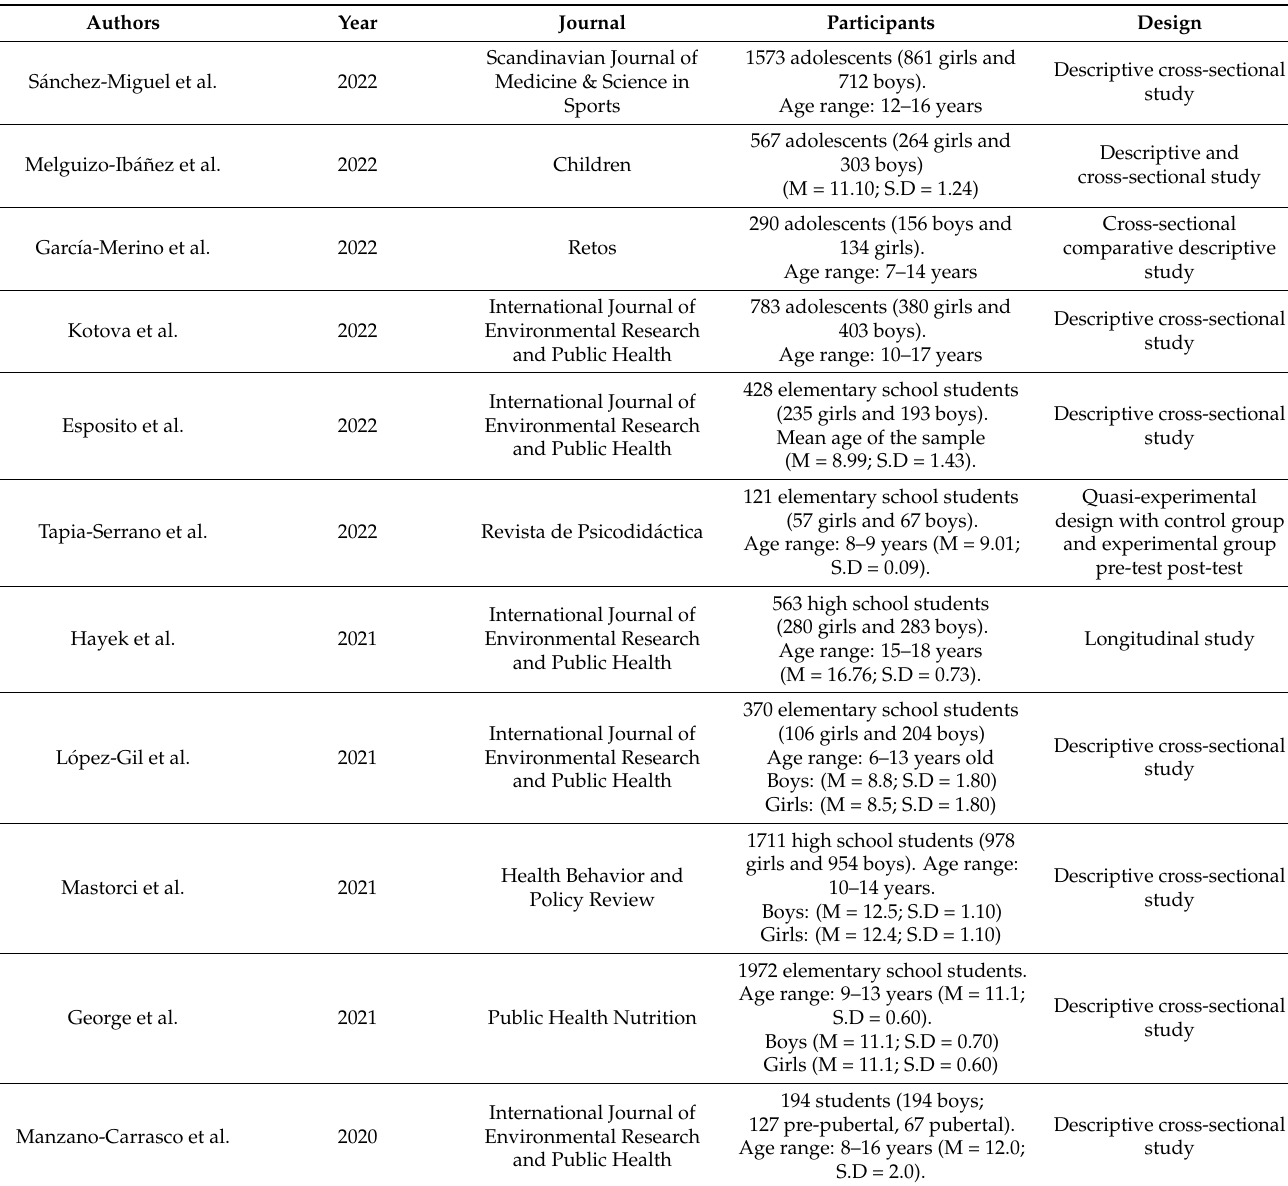
Table 1. Main characteristics of the sample that makes up the